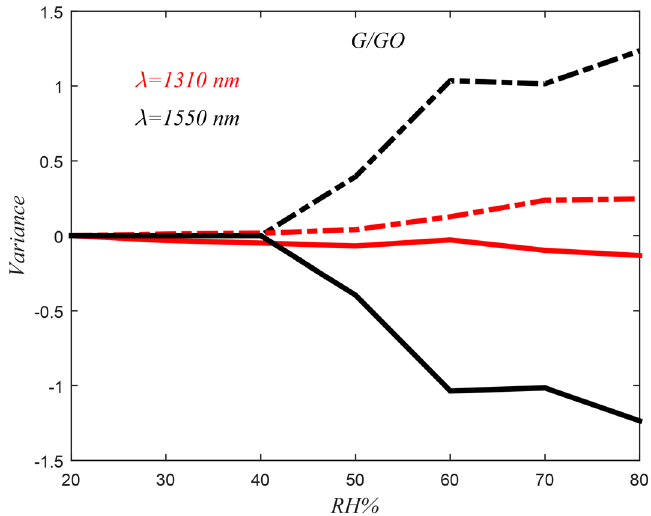
Figure 9. Variance as a function of RH from average values of G/GO-based sensor in 1310 nm and 1550 nm